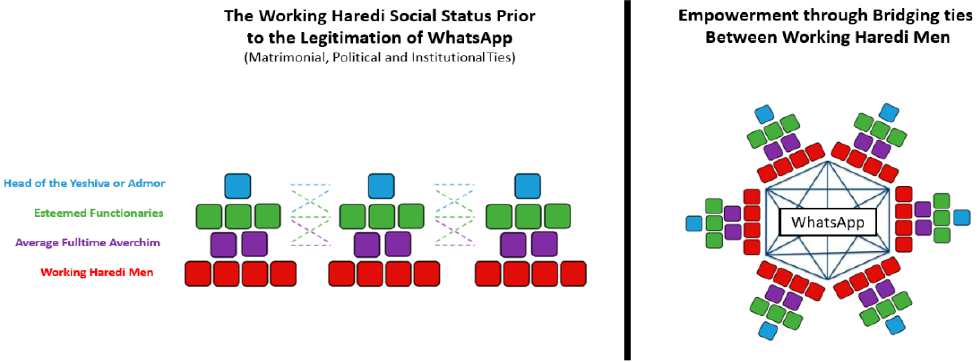
Figure 4. A Schematic Illustration of Haredi Working Men’s